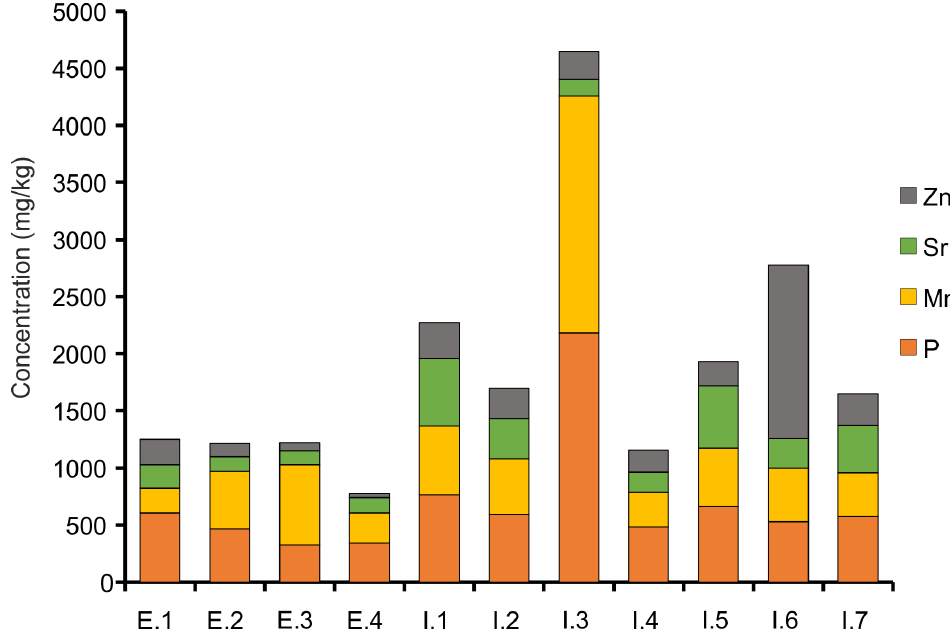
Figure 9. Minor elements concentrations in dusts sampled at the consecutive sites (in mg/kg). Phosphorous (P). The concentrations of P decreased from 607 mg/kg in the sample taken outdoors (E.1) to 309 mg/kg at the end of underground dust accumulation near the outlet air inlet shaft (E.4). At the subsequent sampling site (I.1) and in the most samples from the mine interior, the higher values were observed with content in the range of 483– 761 mg/kg. The exception was site I.3, where P concentration was over three times higher (2186 mg/kg).